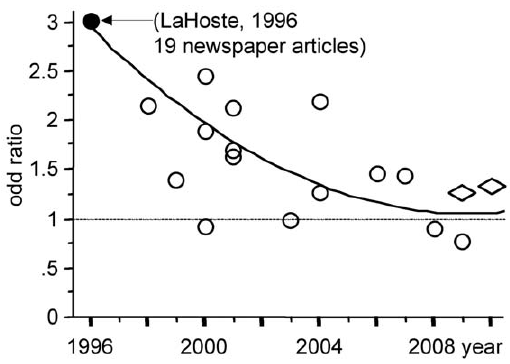
Figure 2. Association between ADHD and the D4 dopaminergic receptor gene in initial and subsequent studies. The strength of the association (i.e. the odd ratio, the ratio of prevalence of the 7R allele of this DRD4 gene in ADHD children versus control children) in each study is given in the ordinate. In 1996 LaHoste and coworkers published the first study associating ADHD with the DRD4 gene [18]. This initial study reported an odd ratio of 3.01. Subsequent case-control studies reported smaller odd ratio (data from table 1A in [47]). According to two recent meta-analyses [46,47], ADHD is still considered to be significantly associated with the DRD4 gene although this association confers a much smaller risk than initially thought (odd ratio indicated by a diamond). Filled circles indicate scientific studies echoed by newspapers (number of media articles indicated in parentheses). Empty circles and diamonds indicate that the publication has not been echoed by newspapers.